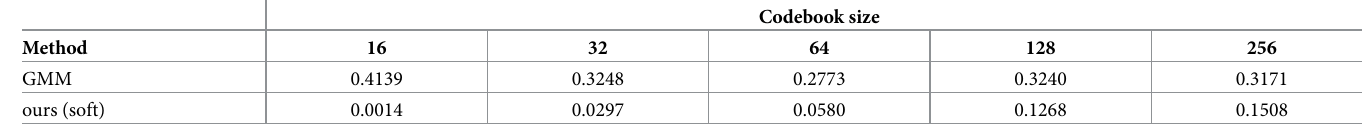
Table 7. The objective values of the GMM and ours with the soft objective with respect to the codebook size on the Birds.